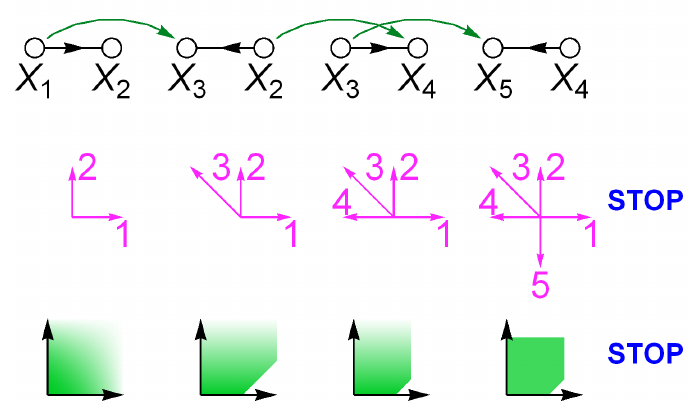
Figure 14 . As we walk on the quiver (first row) we collect the normal vectors (second row) to the facets of the polyhedral regions which eventually produce the associahedron (third row).